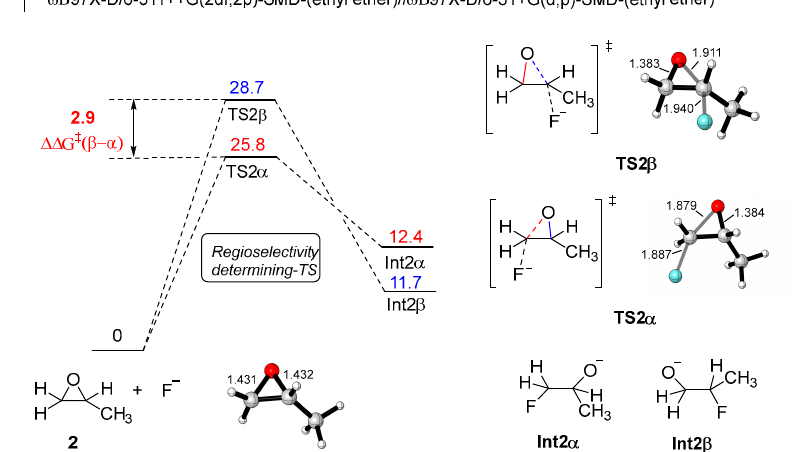
Figure 1. Gibbs free energy profiles for the ring-opening reaction of 1 ( a ) and 2 ( b ). The bond distances are given in angstroms.